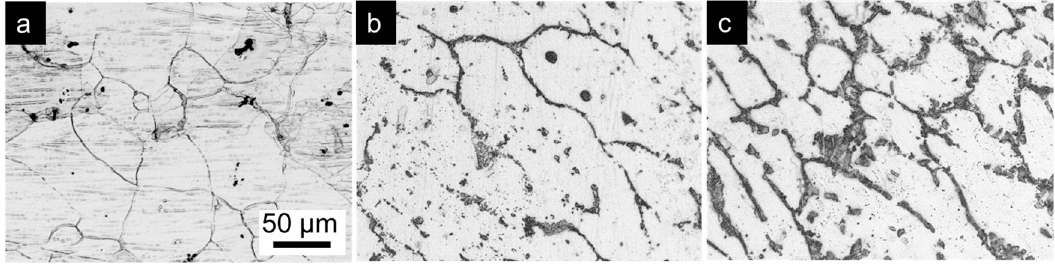
Figure 1. Optical microscopy images of ( a ) AM60; ( b ) AM60-1Ca; and ( c ) AM60-2Ca substrates showing the effect of Ca on the microstructure. The scale bar in image (a) applies to all images.